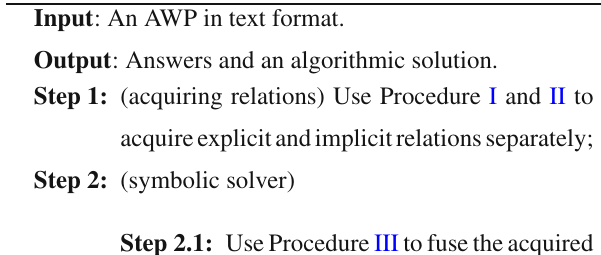
Algorithm I: The Algorithm for Solving